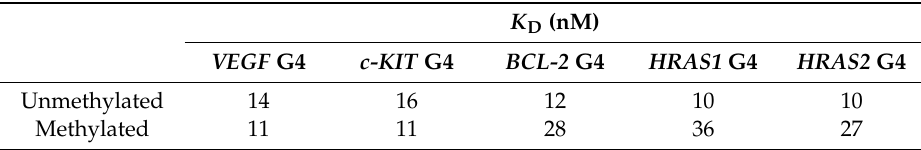
Table 2. K D of unmethylated or methylated VEGF , c-KIT , BCL-2 , HRAS1, and HRAS2 G4 DNAs for